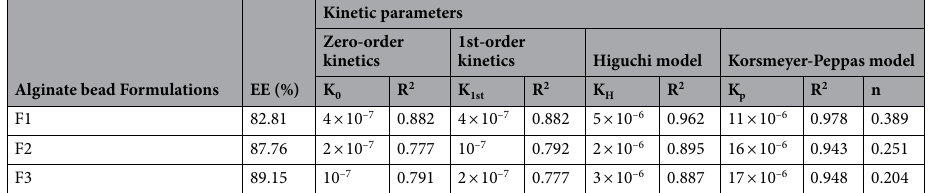
Table 1. In vitro riboflavin release encapsulation efficiency and kinetic parameters.